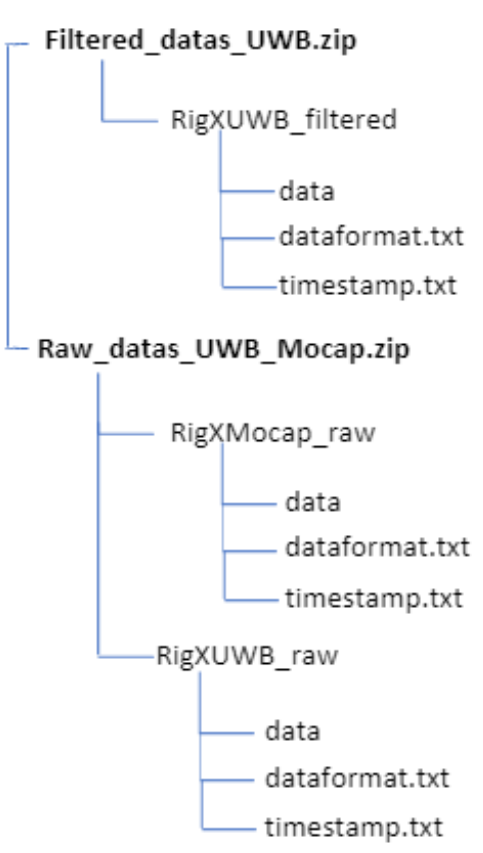
Figure 6. Structure of the provided Zip-Files. X stand for Rig one to Rig six.